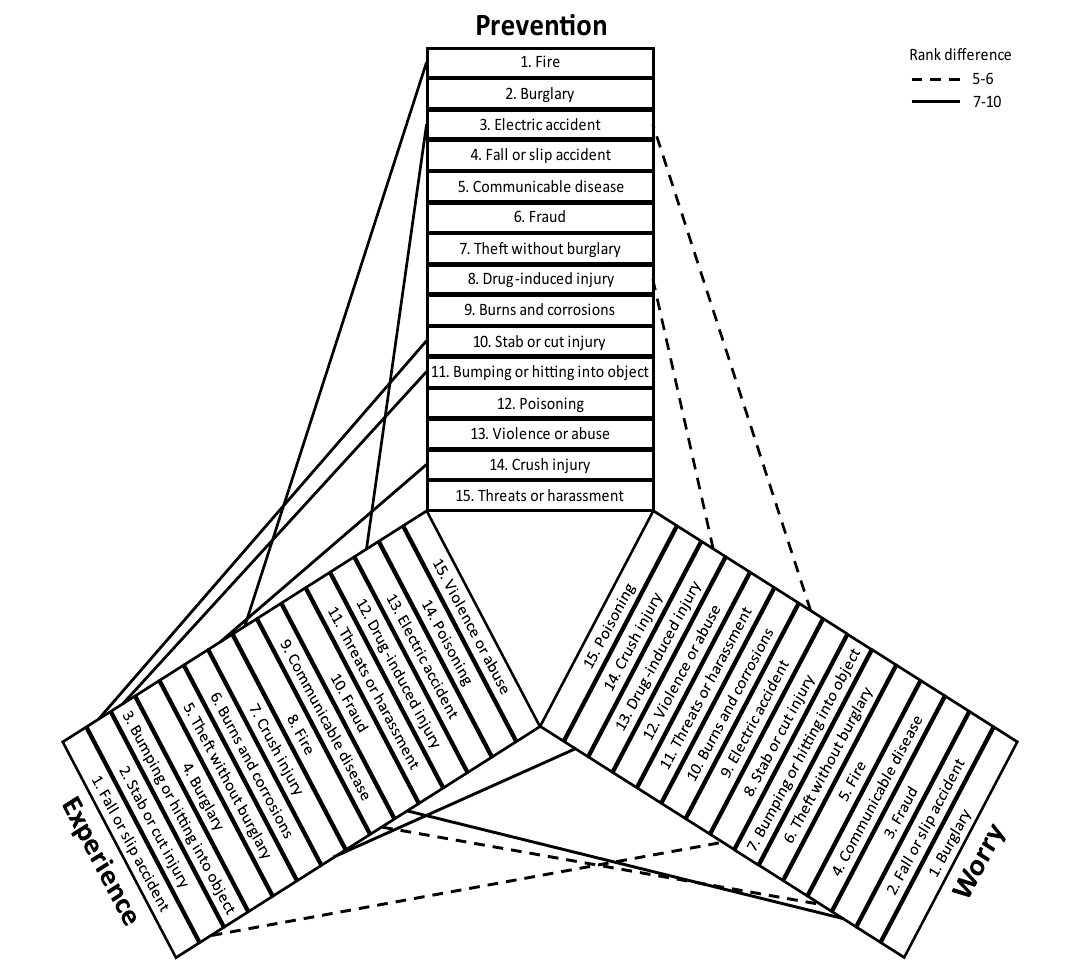
Figure 1. Illustration of the relationships between the sample-level rank order of 15 hazards by prevalence of experience, prevalence of prevention and mean level of worry.